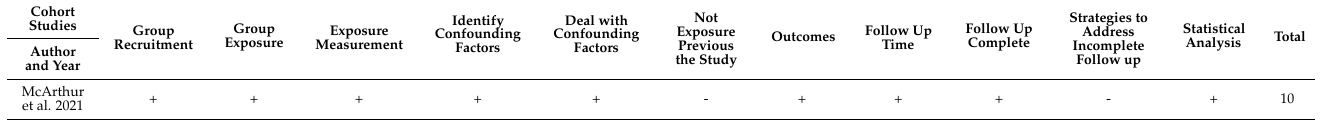
Table 4. Joanna Briggs Institute tool for cohort